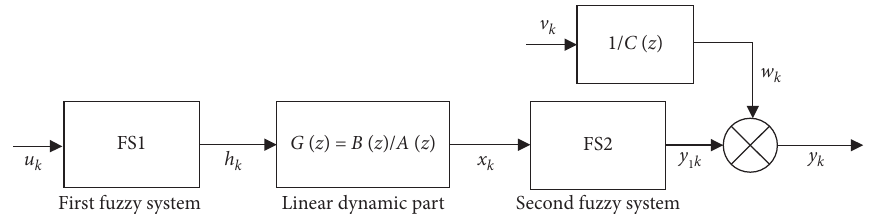
Figure 2: Fuzzy-type stochastic output-error autoregressive Hammerstein–Wiener (FSOEAHW)